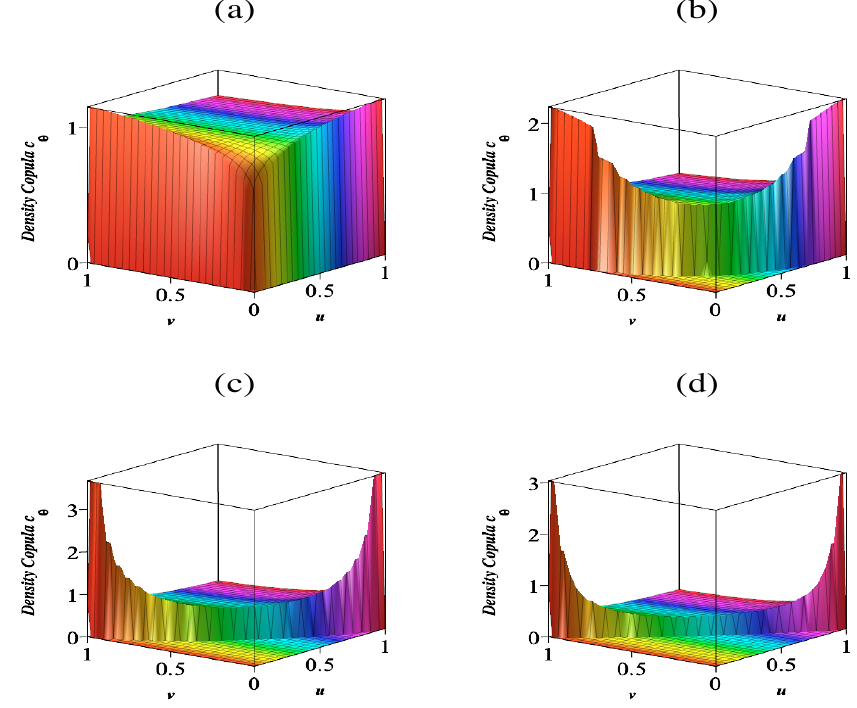
Figure 4. Copula density for ( a ) θ = 0.2, ( b ) θ = 0.5, ( c ) θ = 0.75 and ( d ) θ =